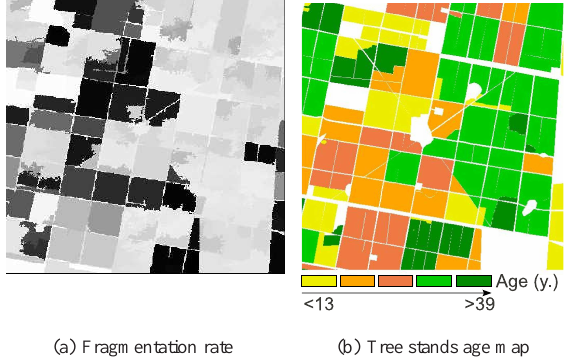
Figure 6: Comparison between the fragmentation rate and the tree stand